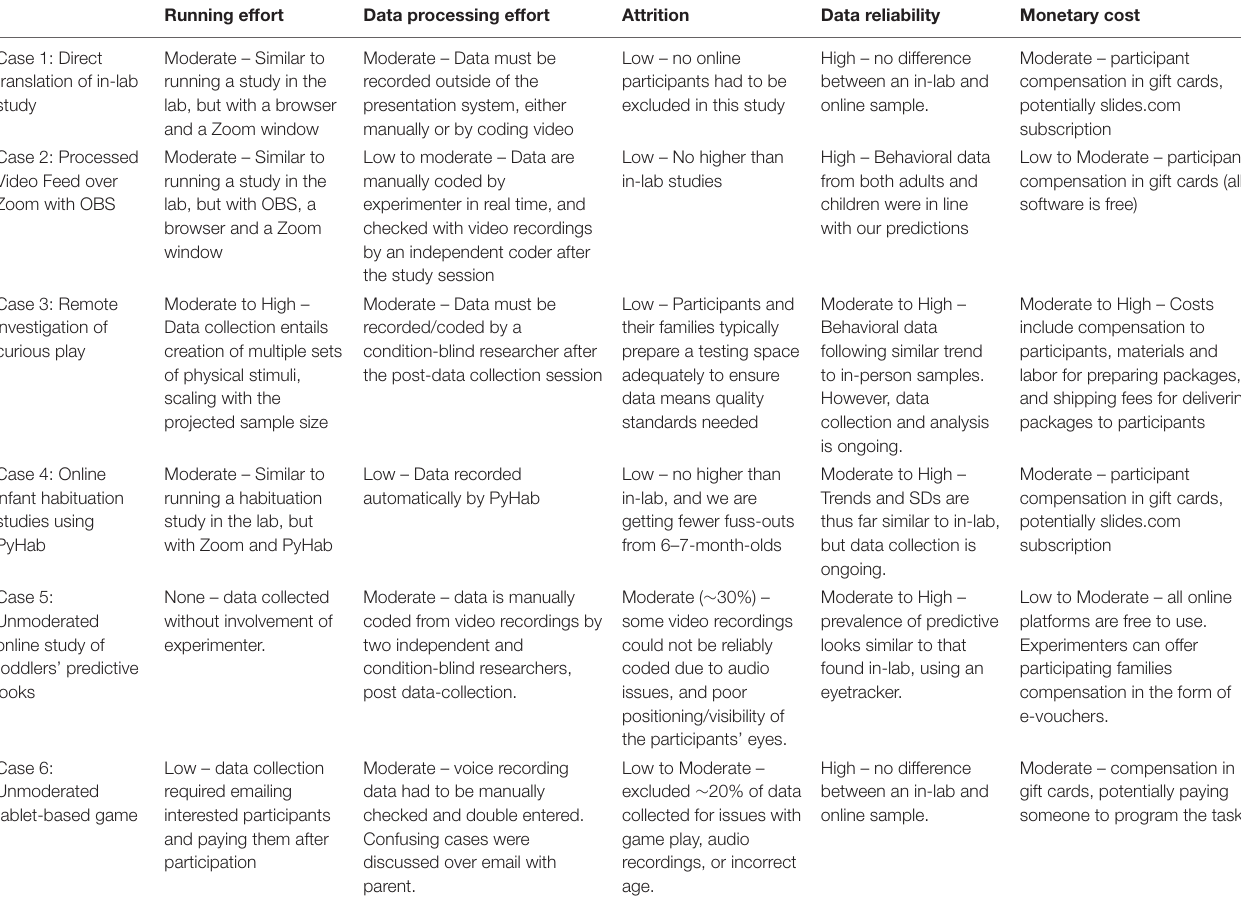
TABLE 1B | Features, advantages, and disadvantages of each of the six case studies with regard to data collection and